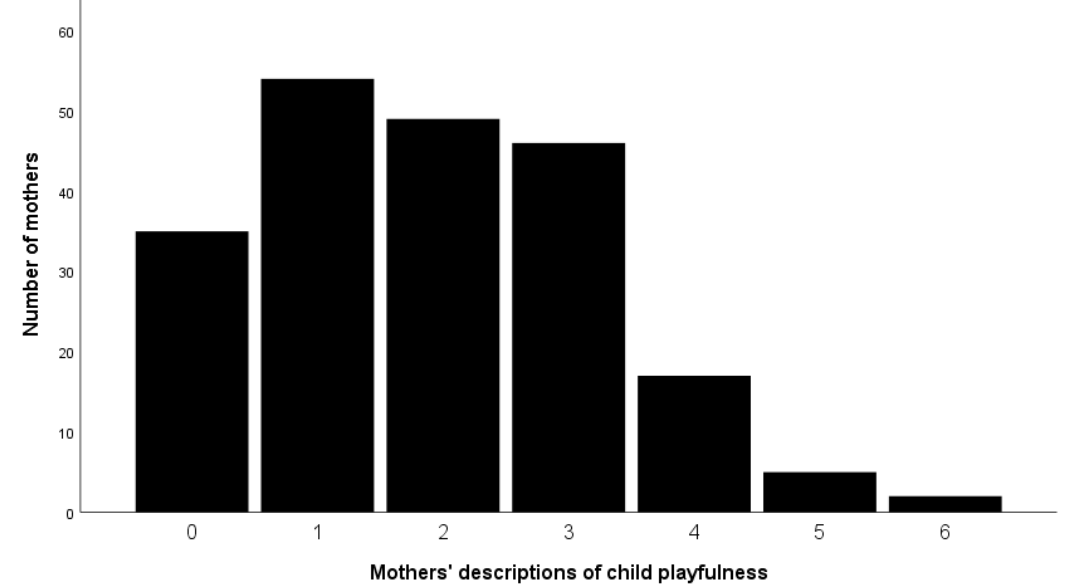
Figure 1. Absolute numbers of mothers’ descriptions of the playfulness of their child ( N = 208).